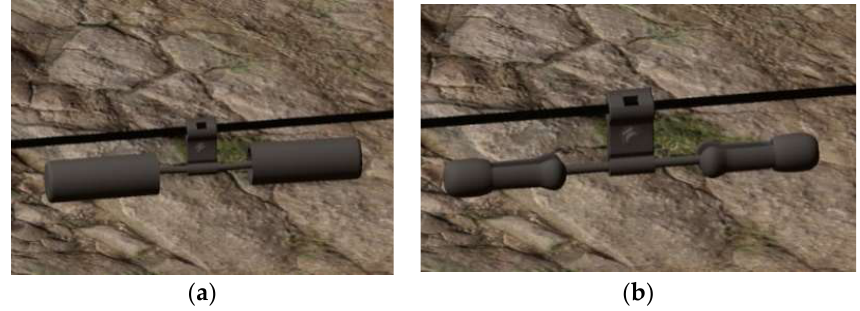
Figure 6. The two types of vibration-dampers. ( a ) FD type; ( b ) FR type.